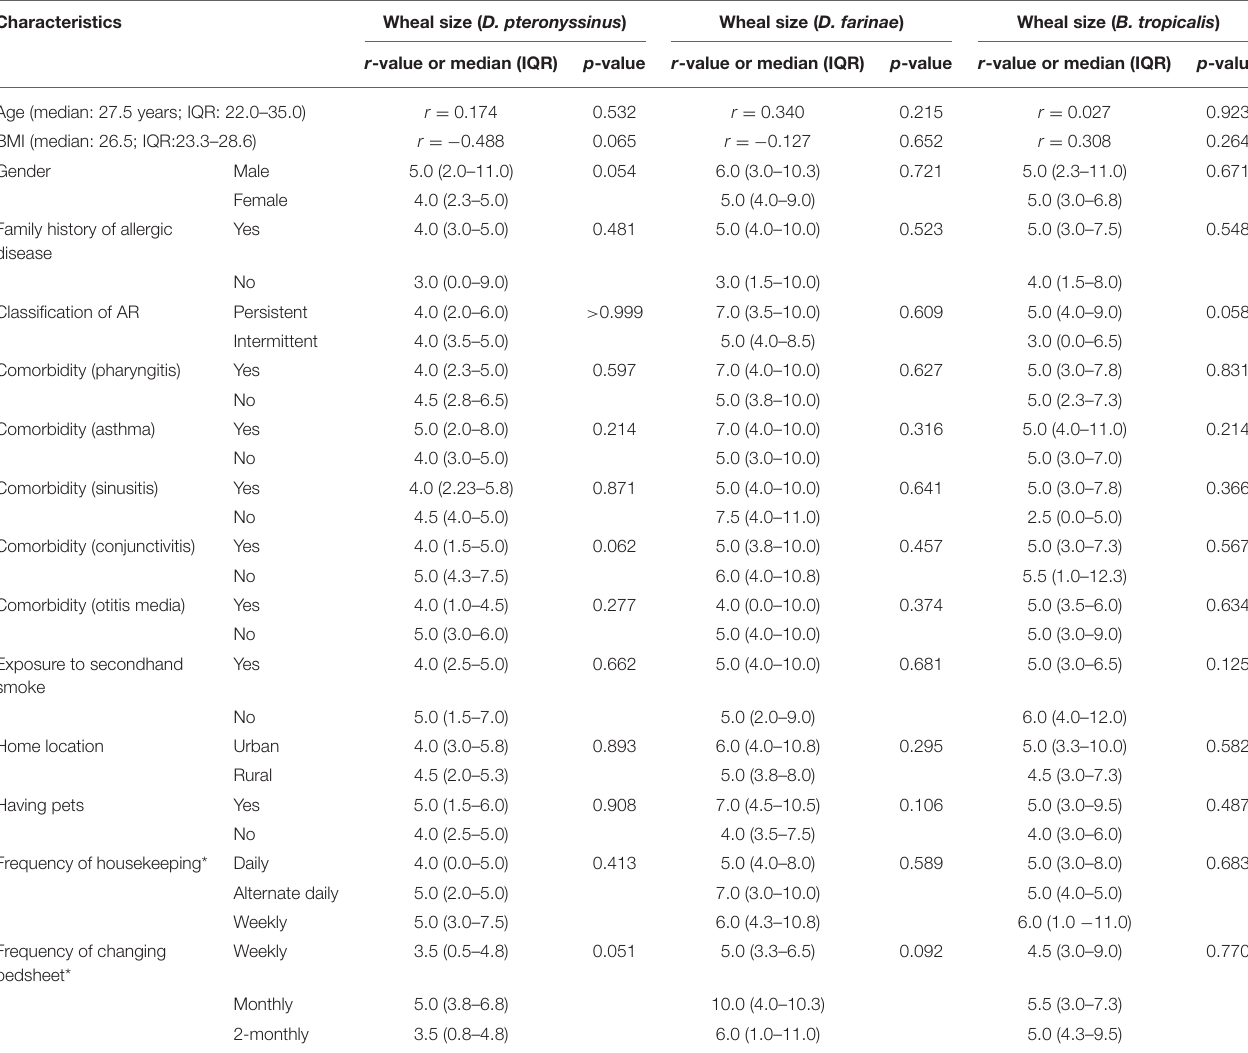
TABLE 1 | Association of clinico-demographical and environmental characteristics with SPT wheal sizes of HDM allergens in AR patients ( n = 30).